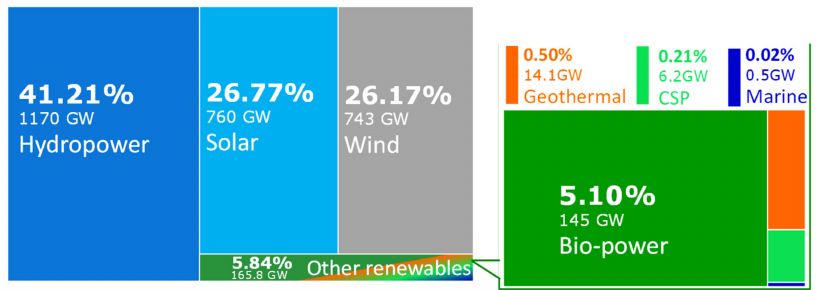
Figure 1. Global renewable generation capacity by energy in 2020 (authors’ creation based on ref.